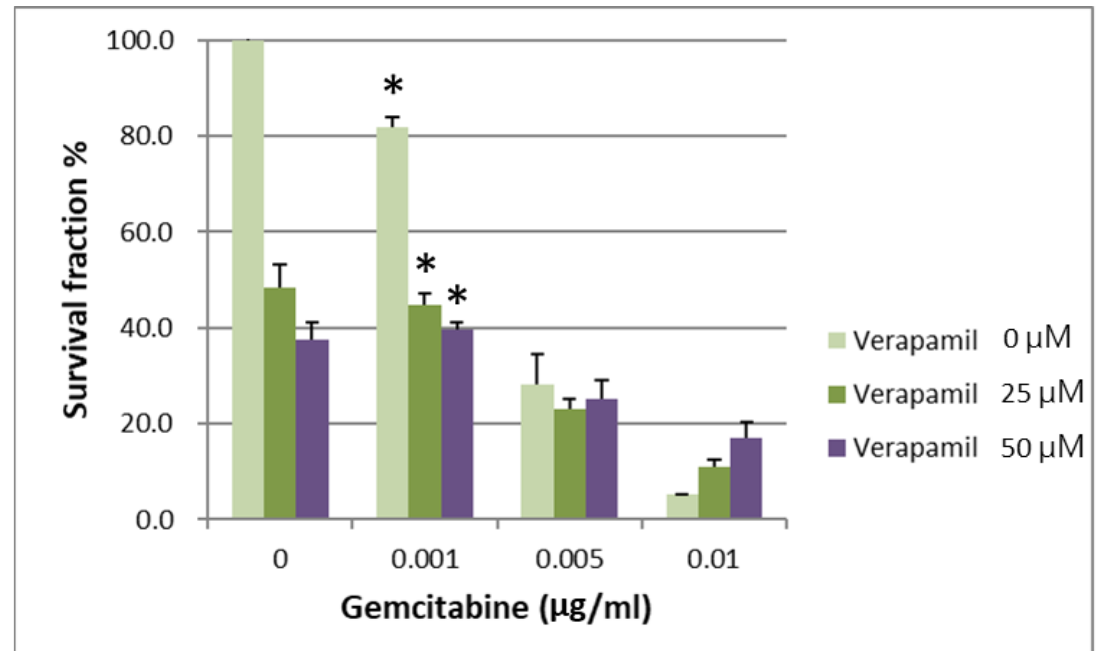
Figure 3. The survival of parental BxPC-3 PDAC cells treated with different concentrations of vera- pamil and gemcitabine is shown. Verapamil 25 and 50 µM exerted the best chemotherapeutic effects when gemcitabine concentration of 0.001 µg/mL was used, * < 0.05. (Mean ± SD).